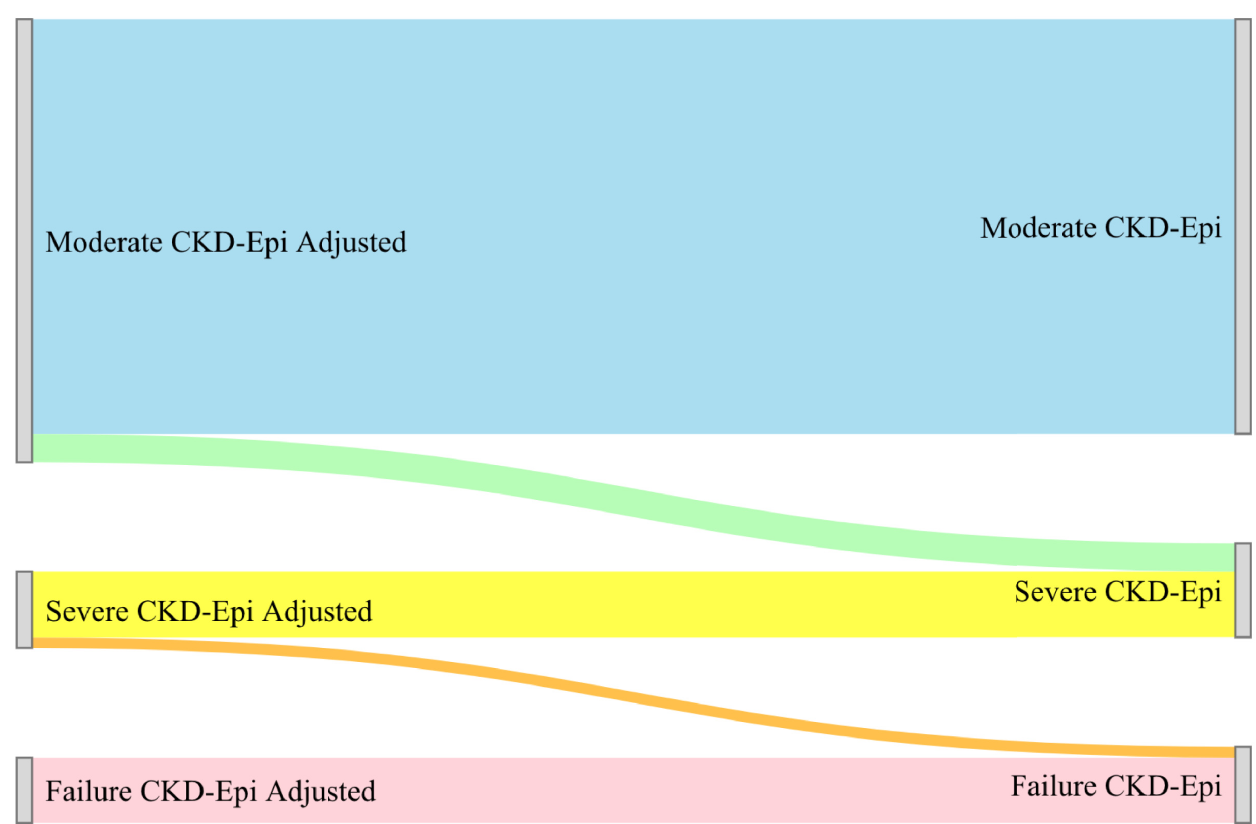
Fig 5. Distribution of estimated glomerular filtration rates by formula. Notes: Legend applies to Figs 4A and 4B. Category color corresponds to vertical axis in matrix. Deviation from the diagonal indicates disagreement between the two measures. White in scatter plot indicates density.